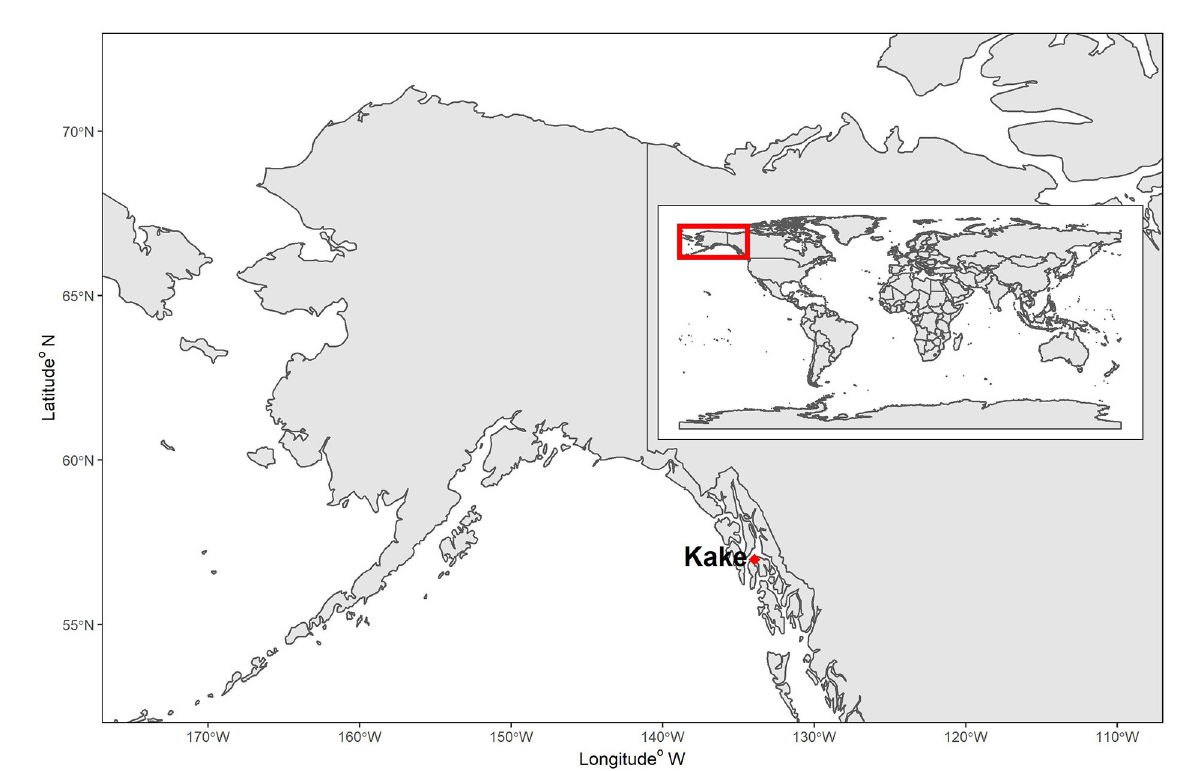
FIGURE3 Alaska in relation to Earth, and Kake in relation to Alaska. Created by M. Rhodes-Reese in Adobe